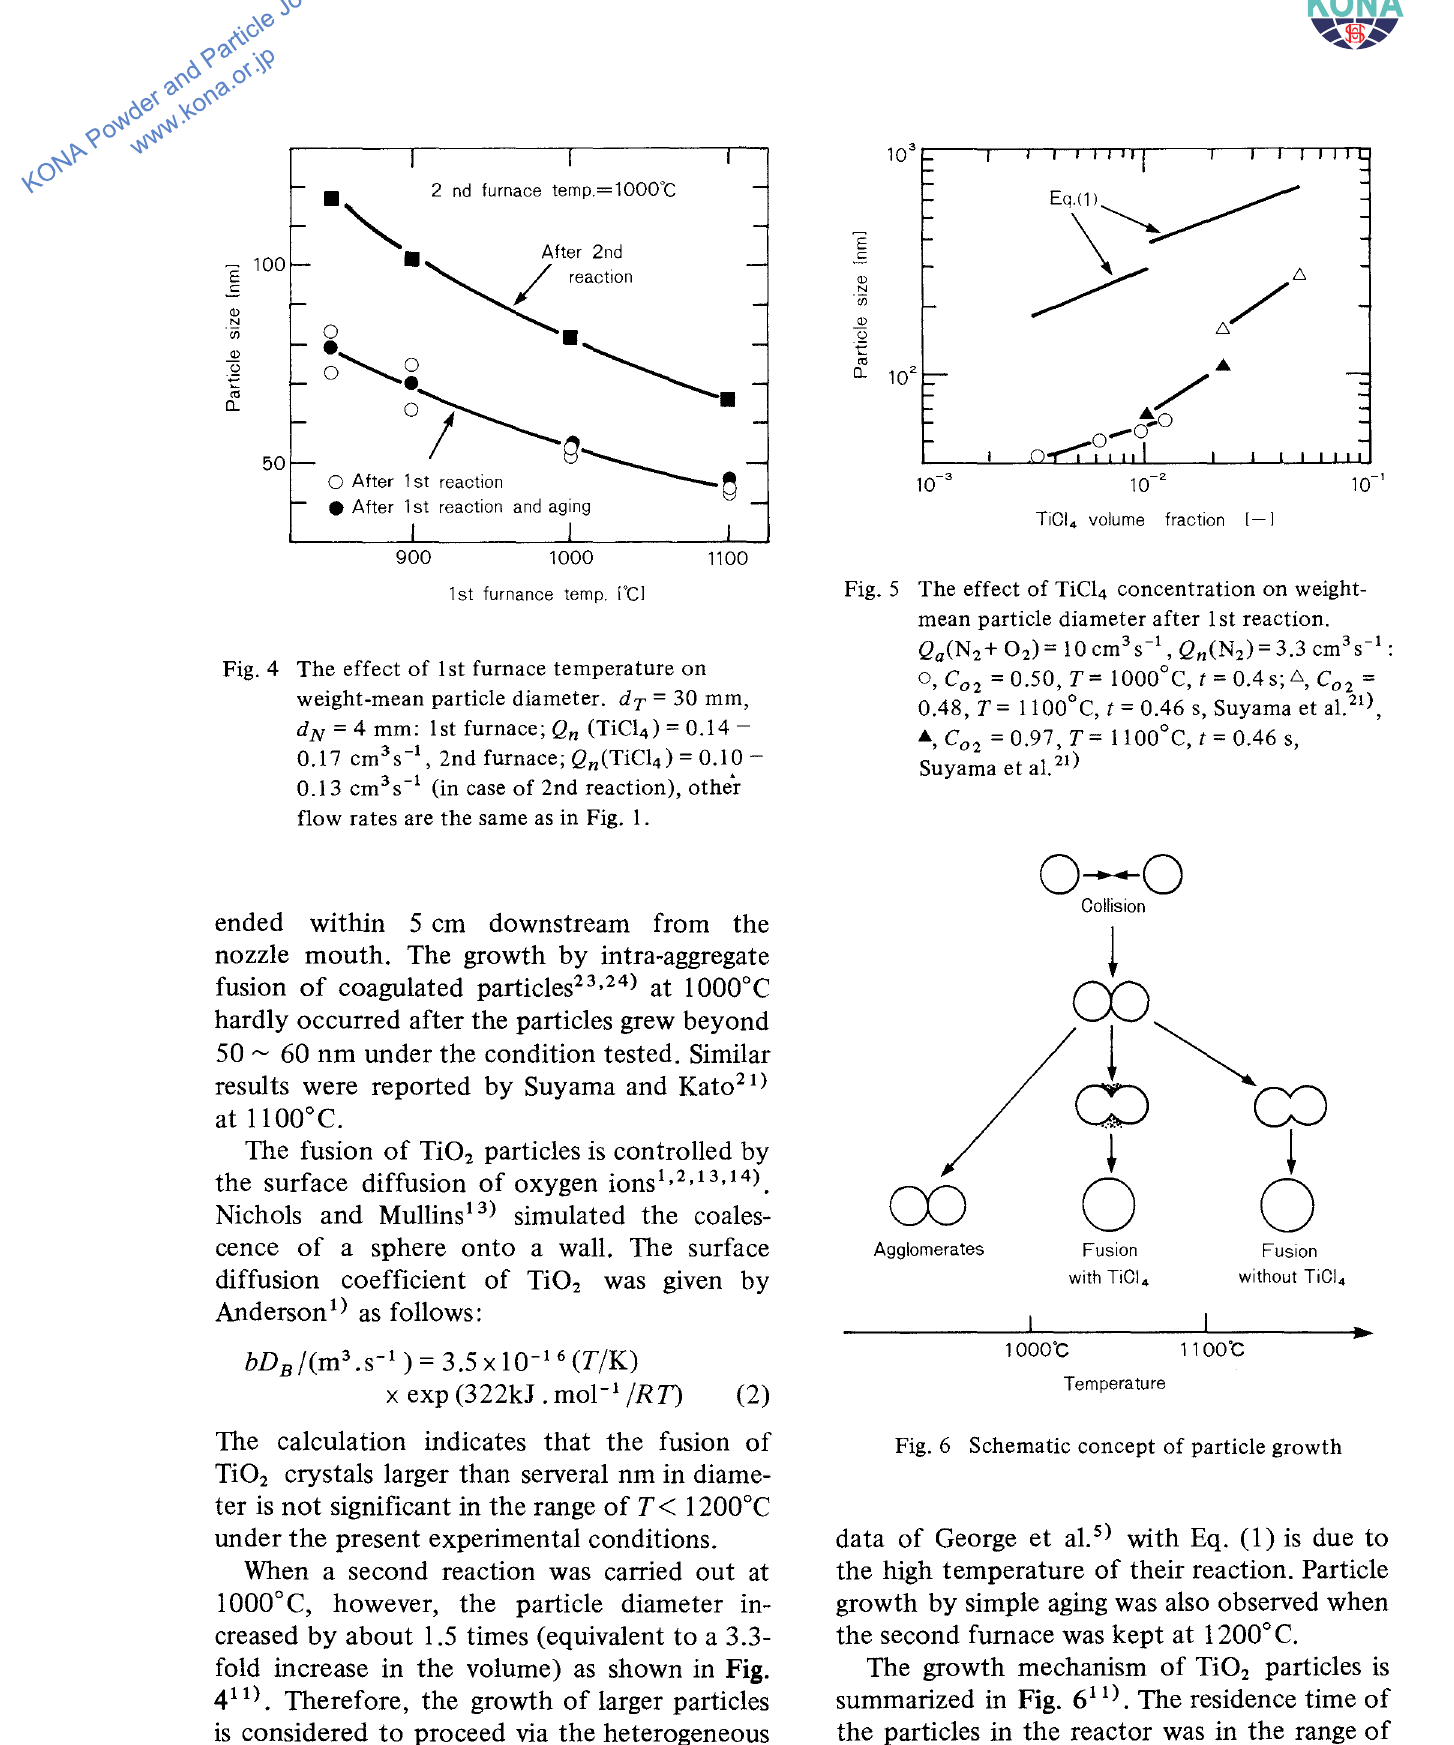
data of George et al. 5 > with Eq. (1) is due to the high temperature of their reaction.